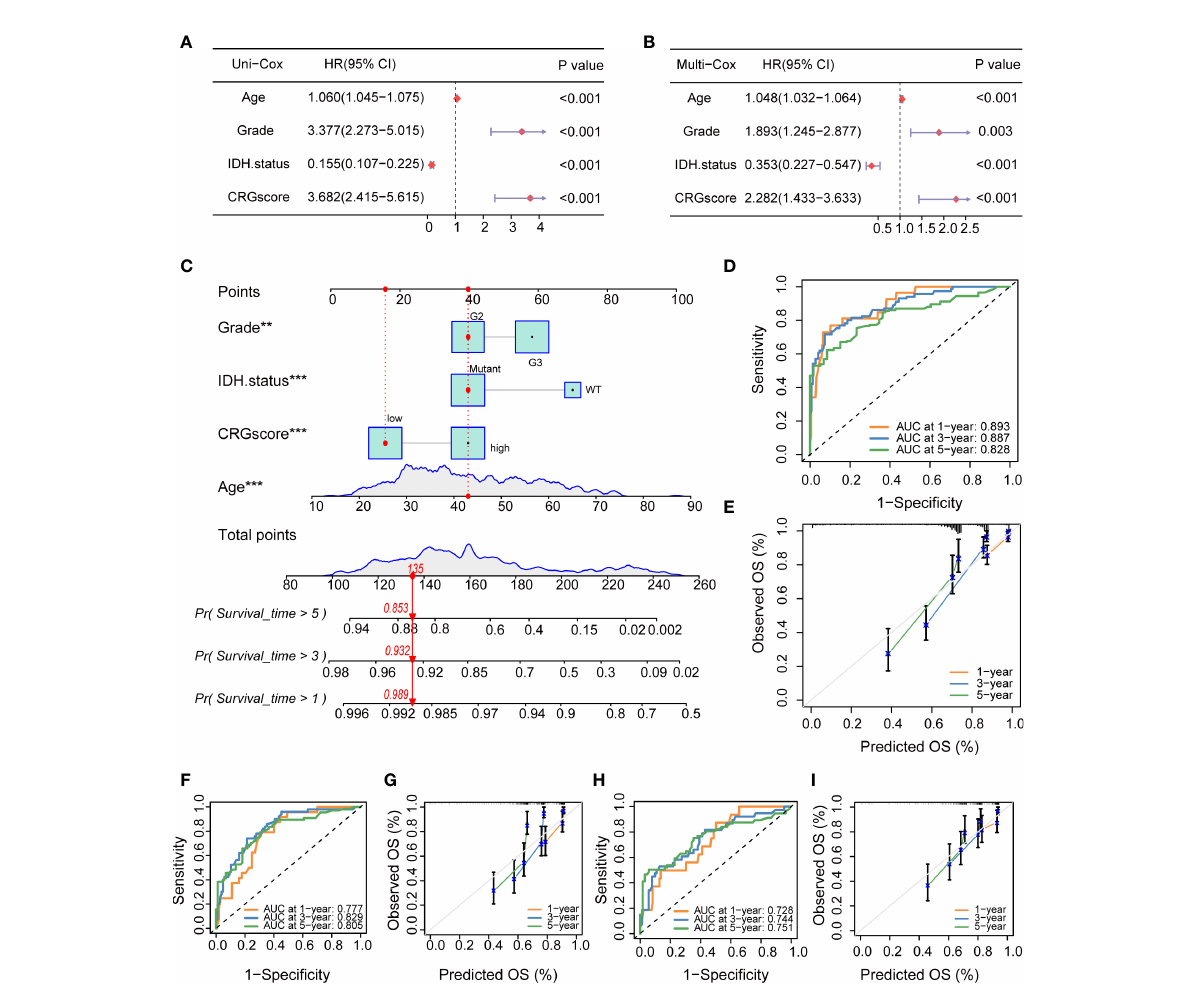
FIGURE 13 Independent prognostic analysis and establishment of a nomogram. (A) Univariate Cox regression analysis of the CRG score and clinical characteristics in the TCGA cohort. (B) Multivariate Cox regression analysis of the CRG score and clinical characteristics in the TCGA cohort. (C) The nomogram was extablished to predict 1-, 3-, and 5-year overall survival probability of LGG patients in the TCGA cohort. (D) ROC curves showed the prognostic performance of the model in the TCGA cohort. (E) The calibration curves measured the relationship between the outcomes predicted by the model and the observed outcomes in the TCGA cohort. (F) ROC curves showed the prognostic performance of the model in the CGGA1 cohort. (G) The calibration curves measured the relationship between the outcomes predicted by the model and the observed outcomes in the CGGA1 cohort. (H) ROC curves showed the prognostic performance of the model in the CGGA2 cohort. (I) The calibration curves measured the relationship between the outcomes predicted by the model and the observed outcomes in the CGGA2 cohort. CRGs, cuproptosis-related genes; TCGA, the Cancer Genome Atlas; LGG, lower-grade glioma (WHO II and III); ROC, receiver operating characteristic; CGGA, Chinese Glioma Genome